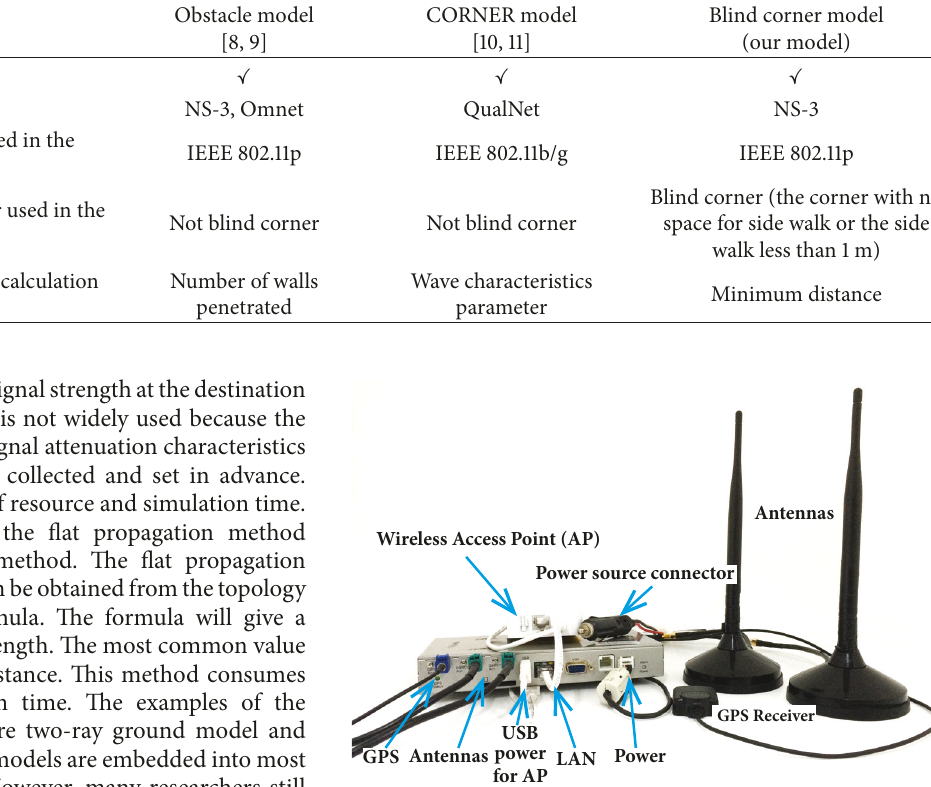
Figure 2: Denso WSU experiment